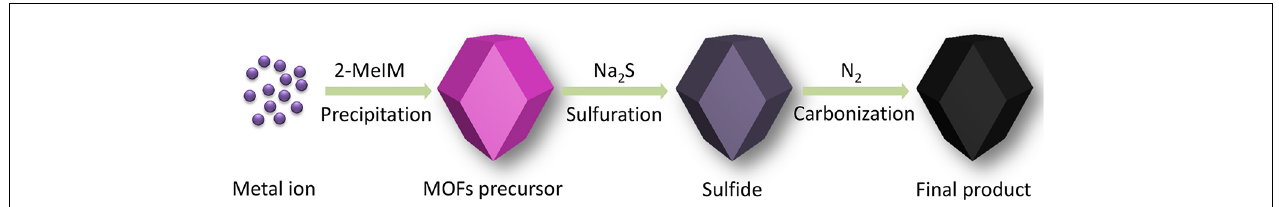
FIGURE 1 | Schematic diagram of the preparation of the Zn/Co/Fe–S–NC catalyst.